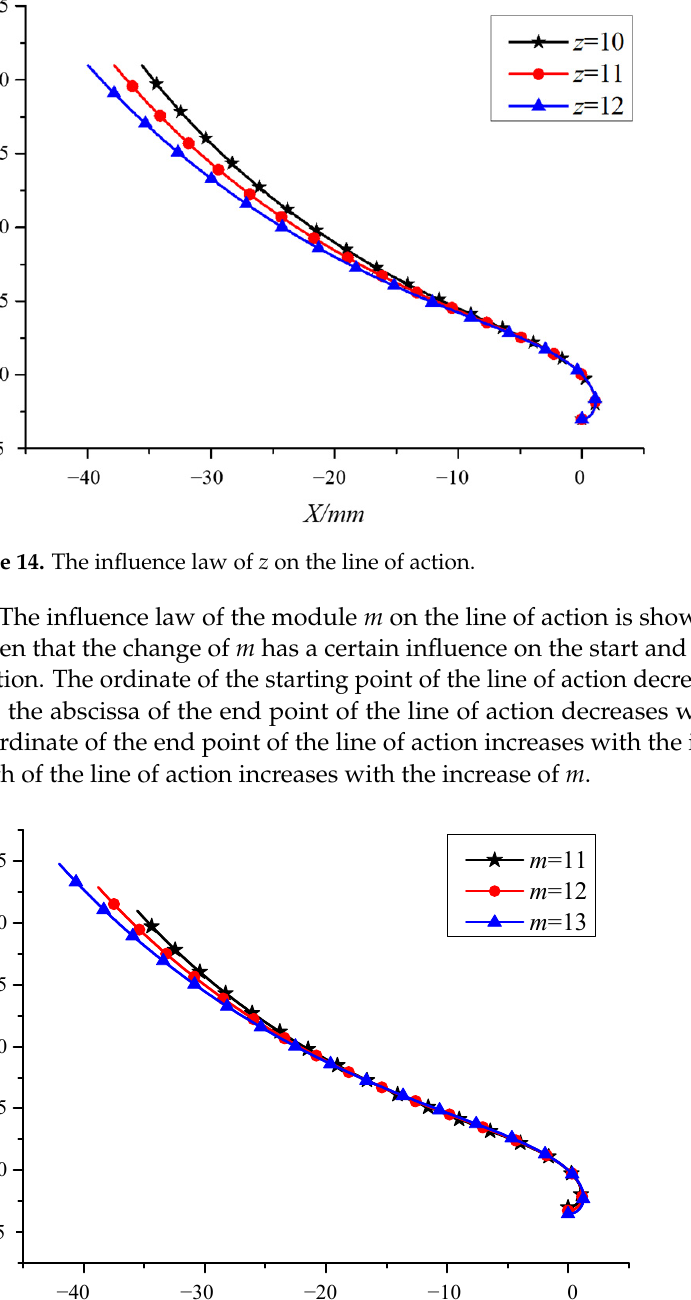
the increase of z .